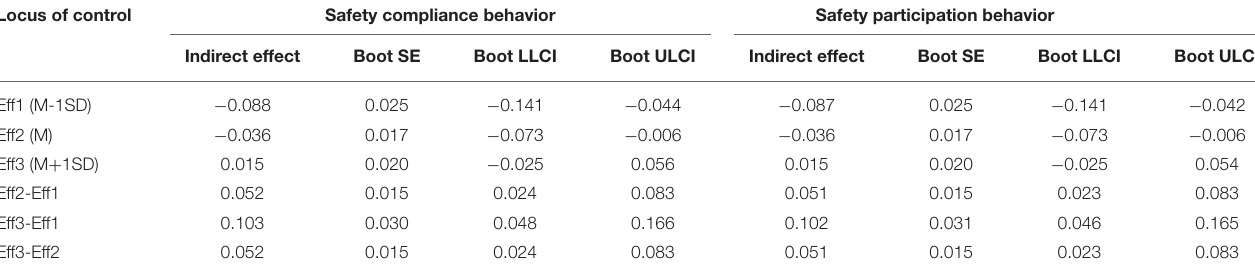
TABLE 6 | Mediating effects at different levels of locus of